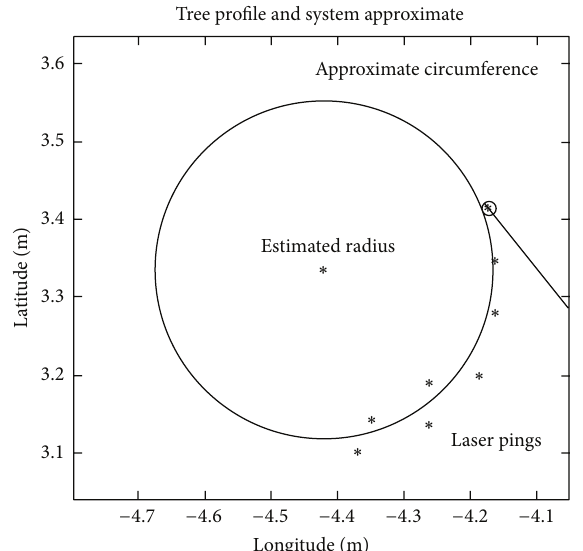
Figure 4: Tree information and trunk approximation.